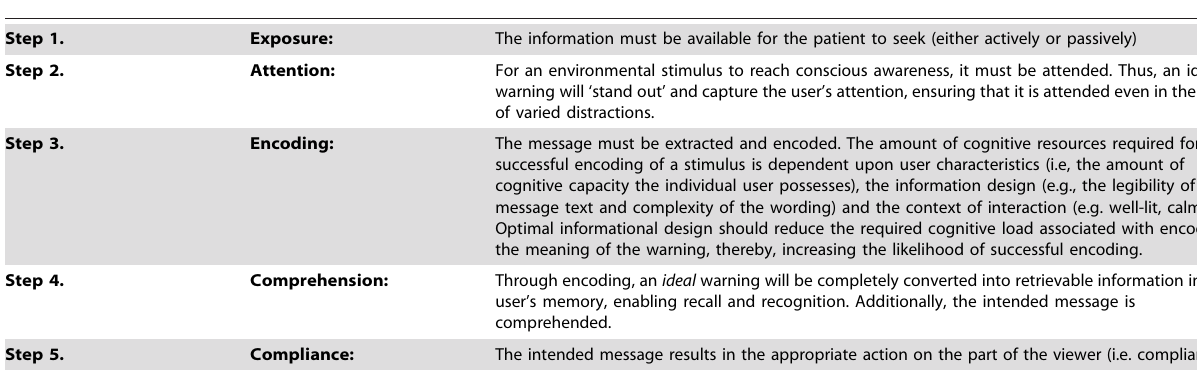
Table 1. Serial steps of a commonly recognized information processing model.